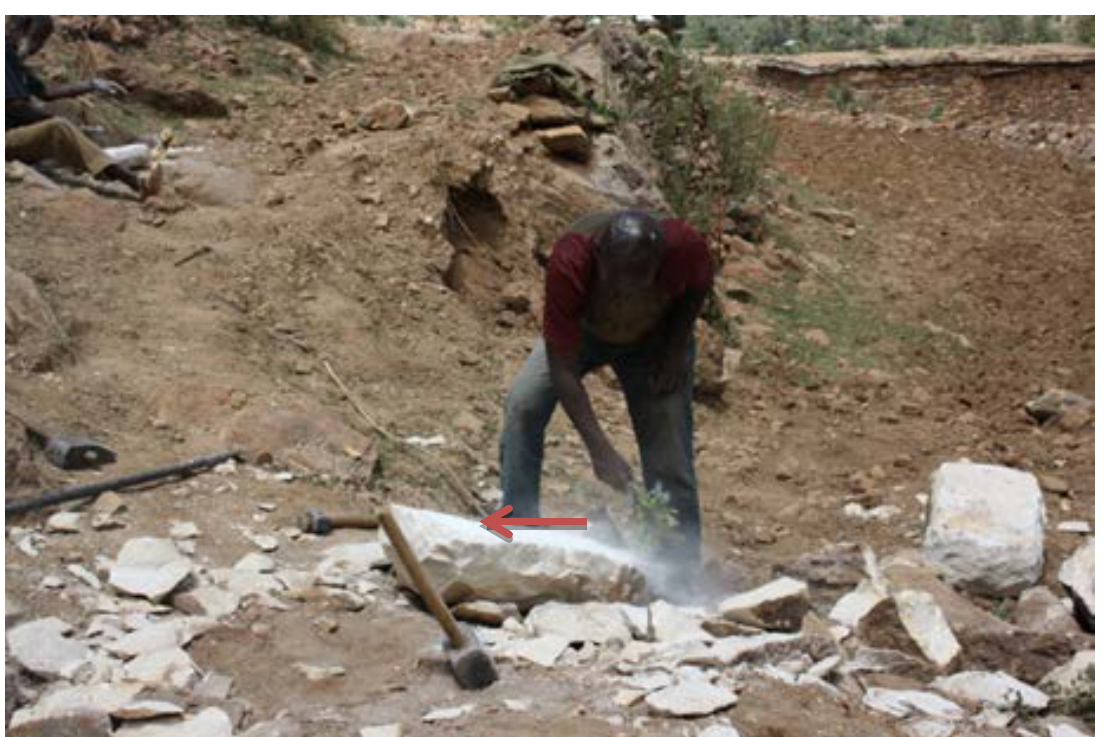
Figure 10. One of the helpers completing finer finishing of ventral (grinding) surface (note supporting stone under